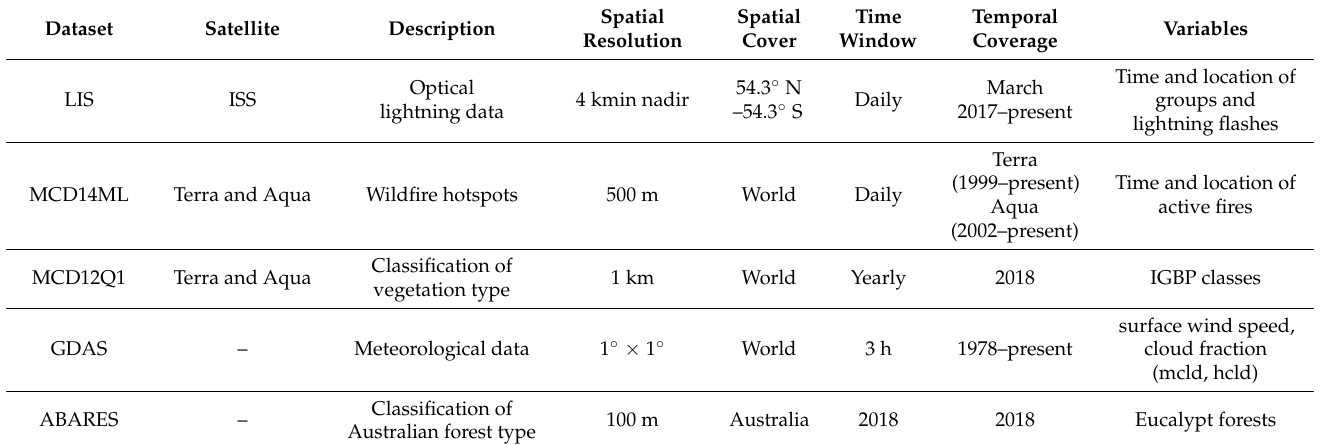
Table 1. The datasets used in this study are presented. References are given above in the text of Section